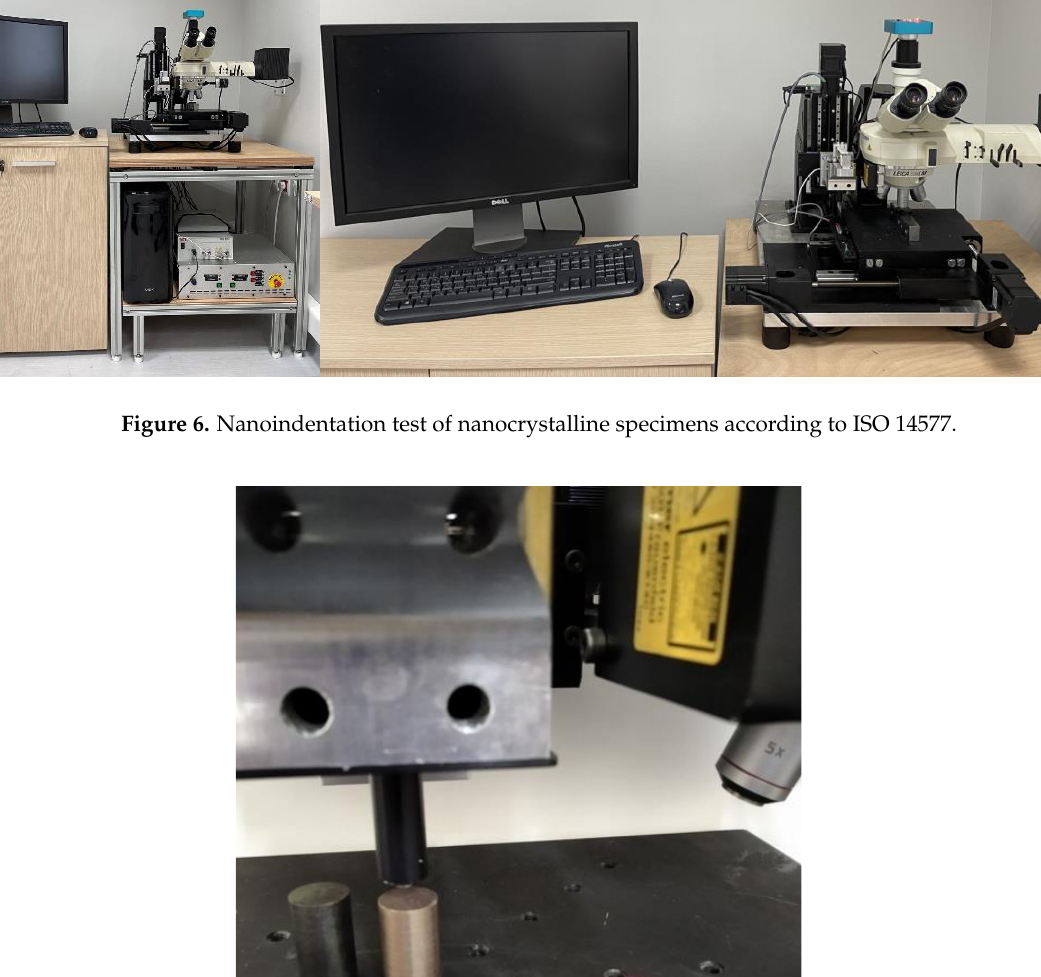
Figure 6. Nanoindentation test of nanocrystalline specimens according to ISO 14577.